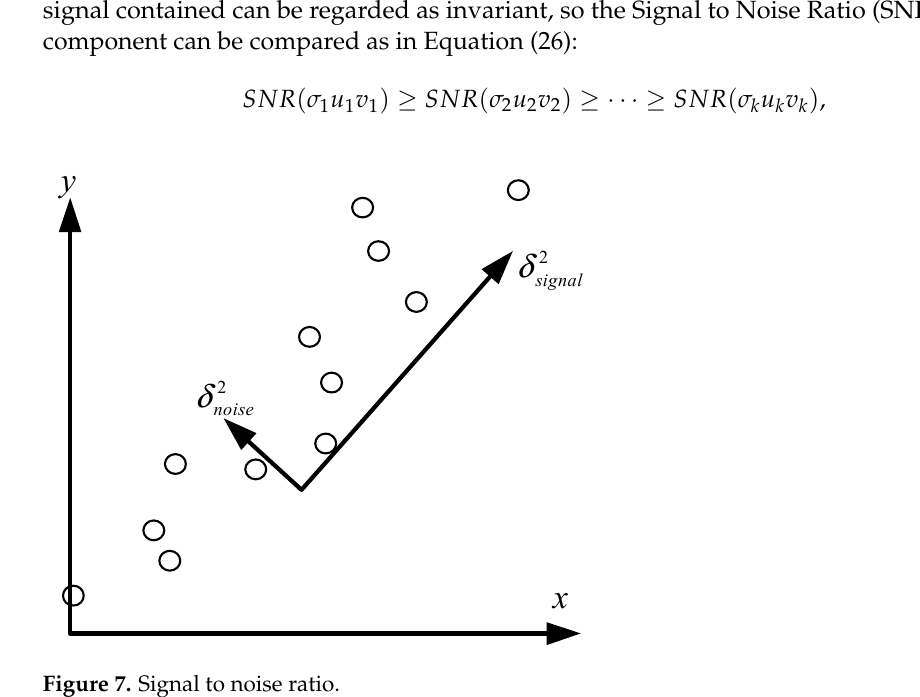
Figure 7. The component size of each order principal component is different, but the noise